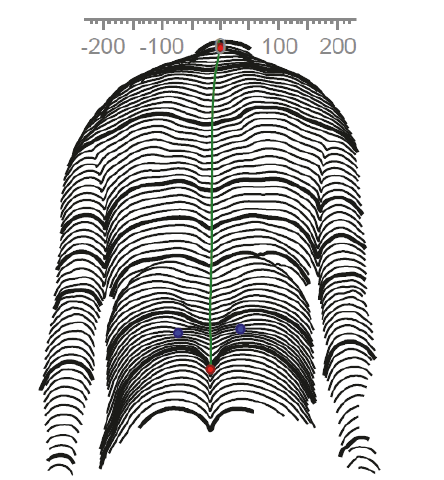
Figure 1: View of the raster lines on a patient’s back. Blue dots: left and right lumbar dimples. Lower red dot: dimple mid-point (DM).